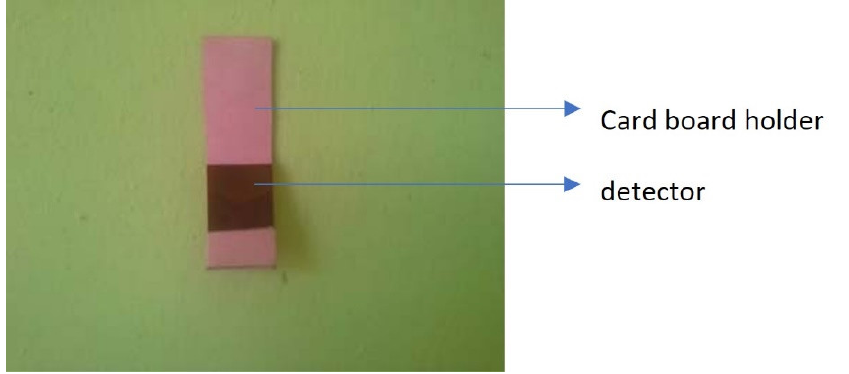
Figure 2. Self-made device deployed in the dwellings.